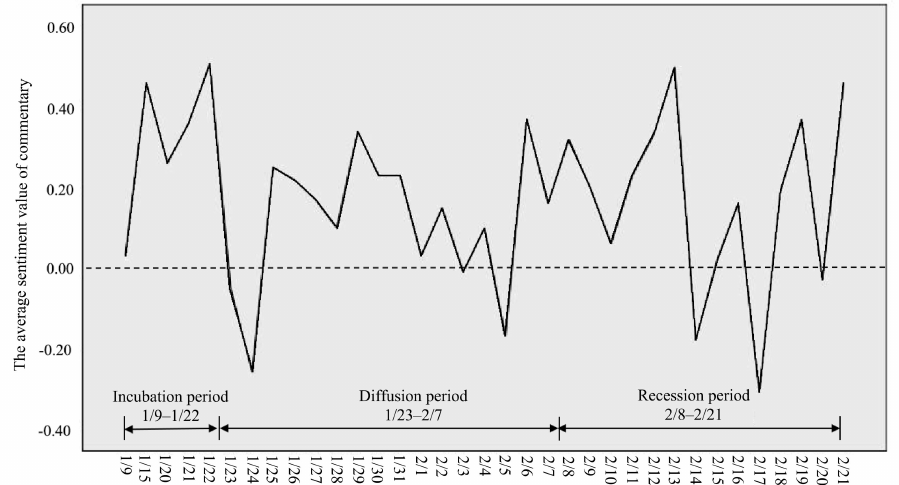
Figure 3. Sentiment Value Change of Weibo Hot Search